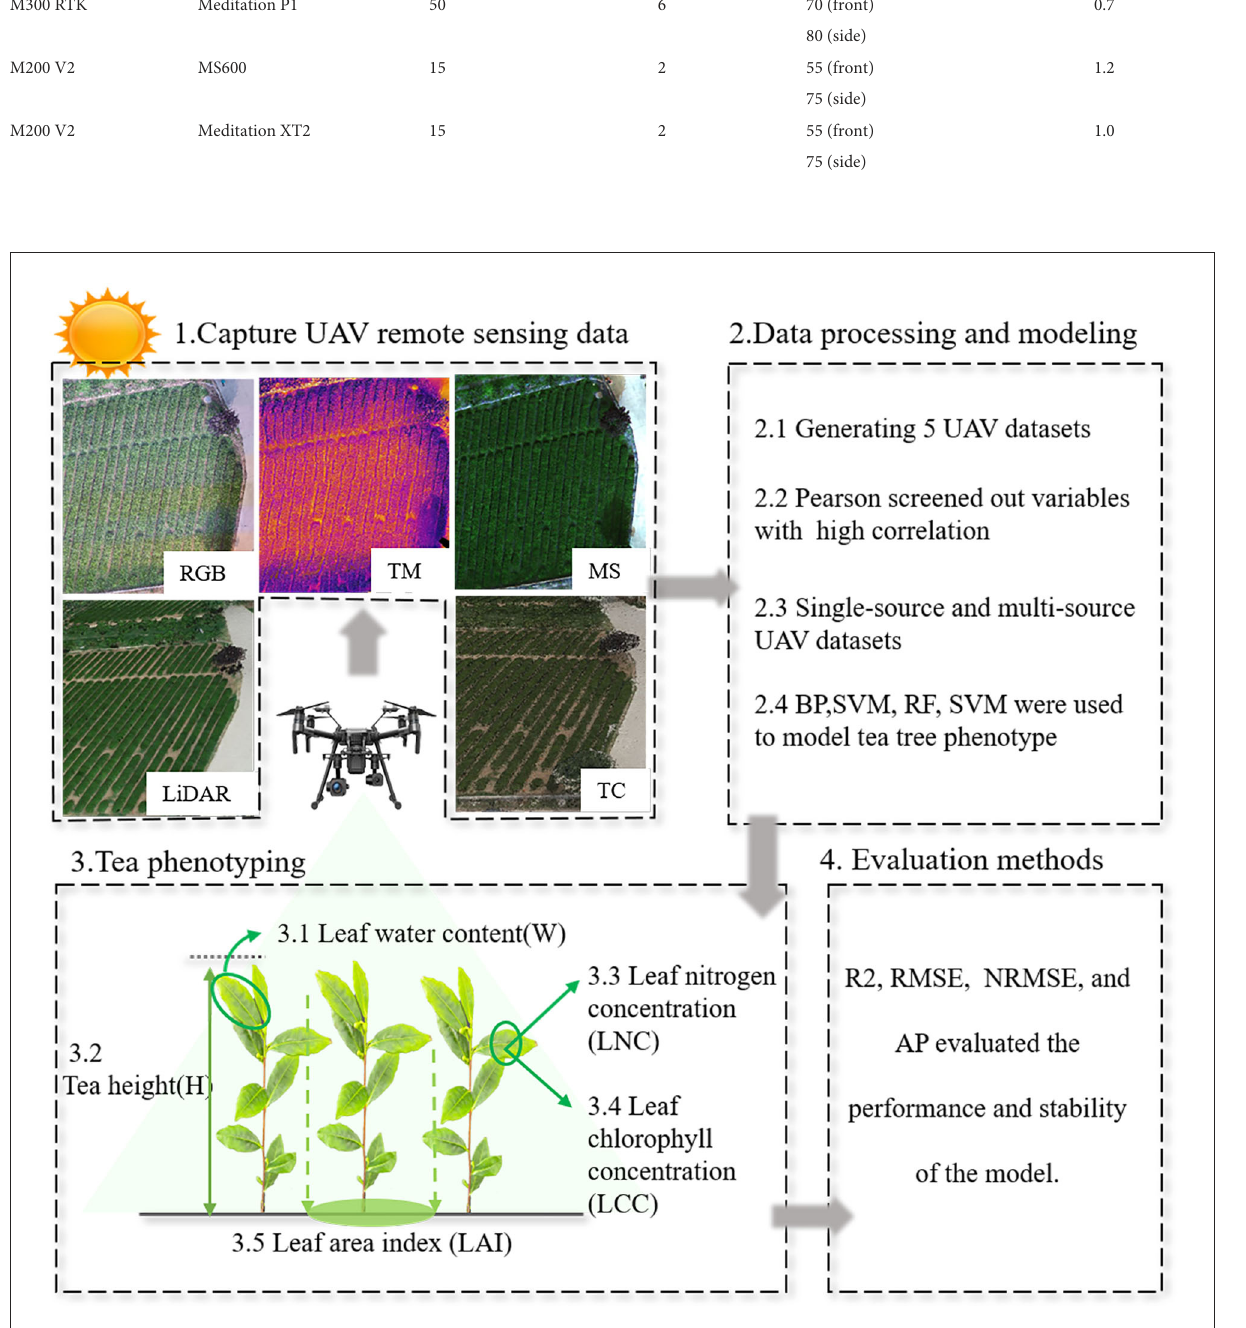
FIGURE4 General framework for evaluating tea phenotype based on multi-source remote sensing